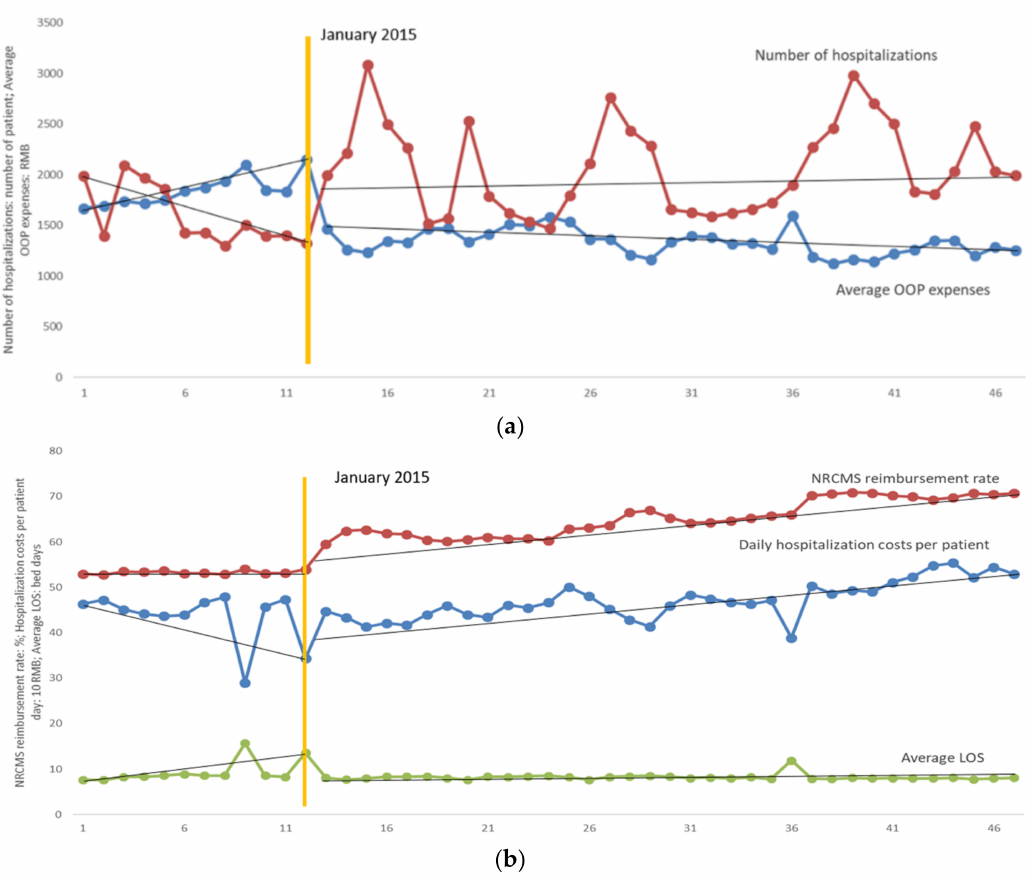
Figure 2. ( a ) Impacts of full coverage of essential (FCEMs) policy on average out-of-pocket (OOP) expenses and number of hospitalizations. ( b ) Impacts of FCEMs policy on average length of stay